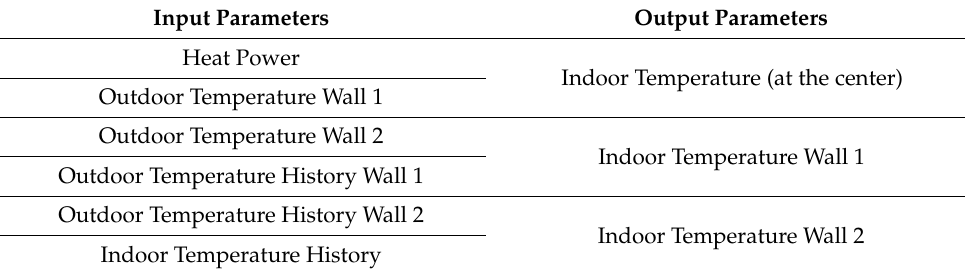
Table 2. Input and output parameters of the ML